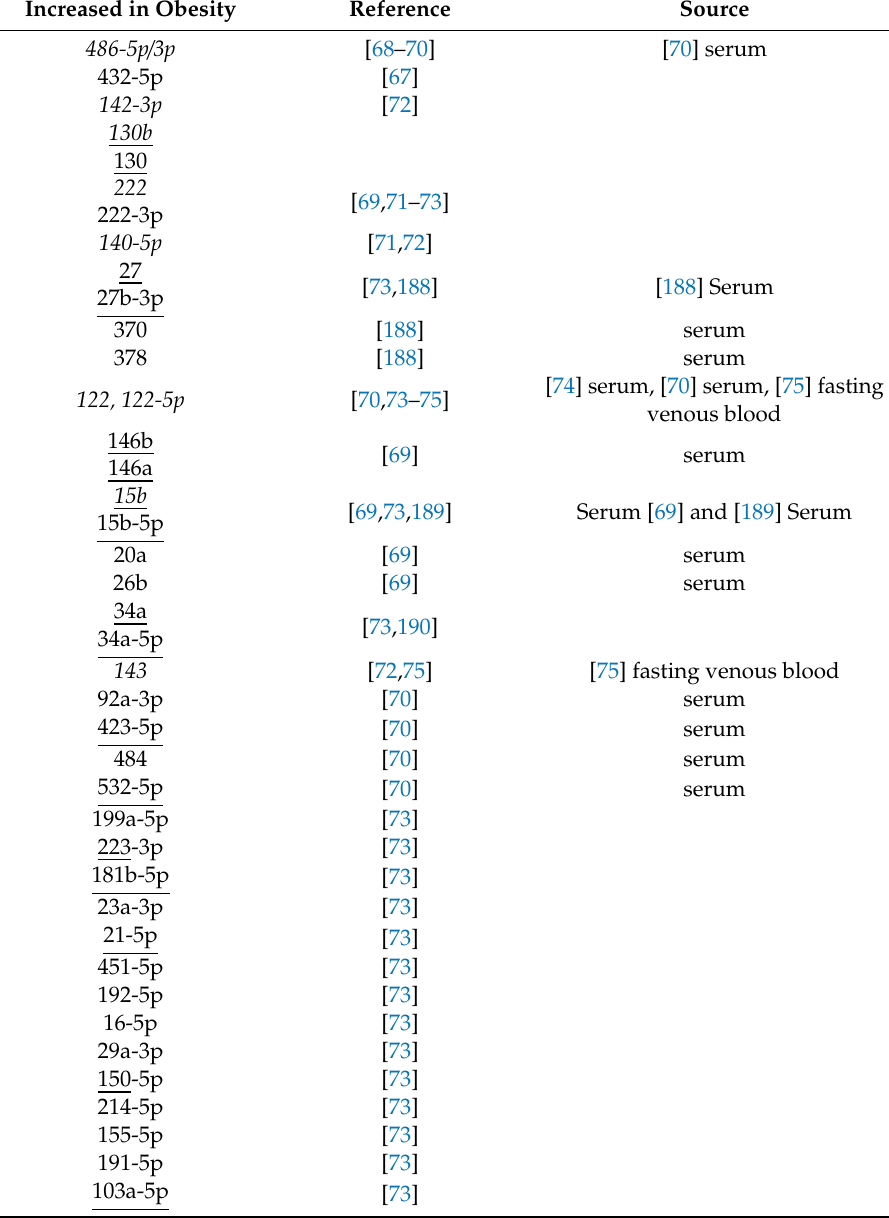
Table A1. Circulating miRNAs increased in obesity (adapted from [67]). MiRNAs detected in plasma unless otherwise stated in the Source column. Italic text indicates the miRNA was found to be altered in this direction in more than 1 study. Underlined text indicates a contradictory finding where the miRNA was found to be up-regulated in at least one study and down-regulated in at least one other (see Table